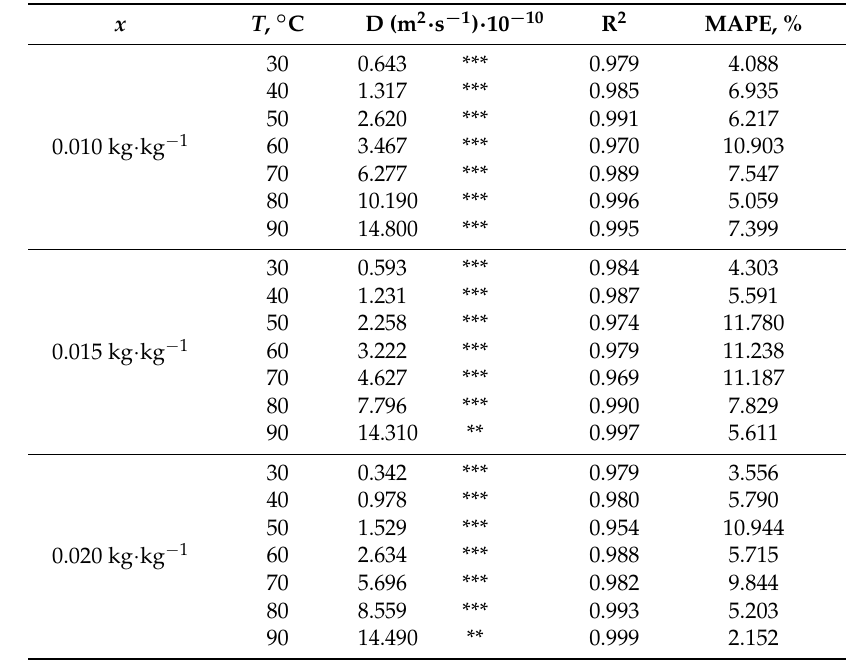
Table 3. Moisture diffusion coefficients D for short times (MR ≥ 0.2), calculated with Equation (5) for different absolute humidity x and temperature T of the drying air, coefficient of determination R² and MAPE.